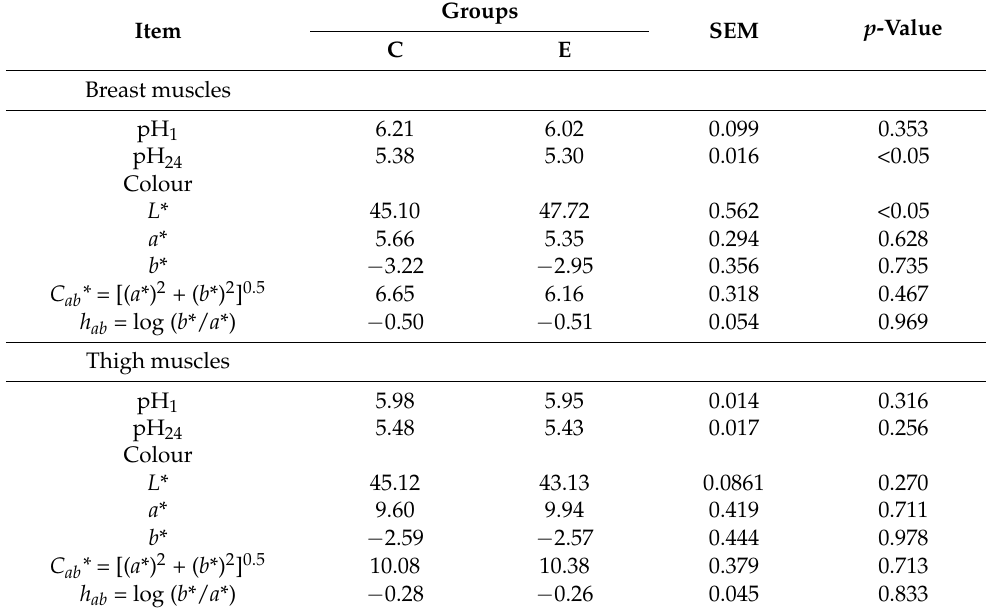
Table 6. Physical properties of